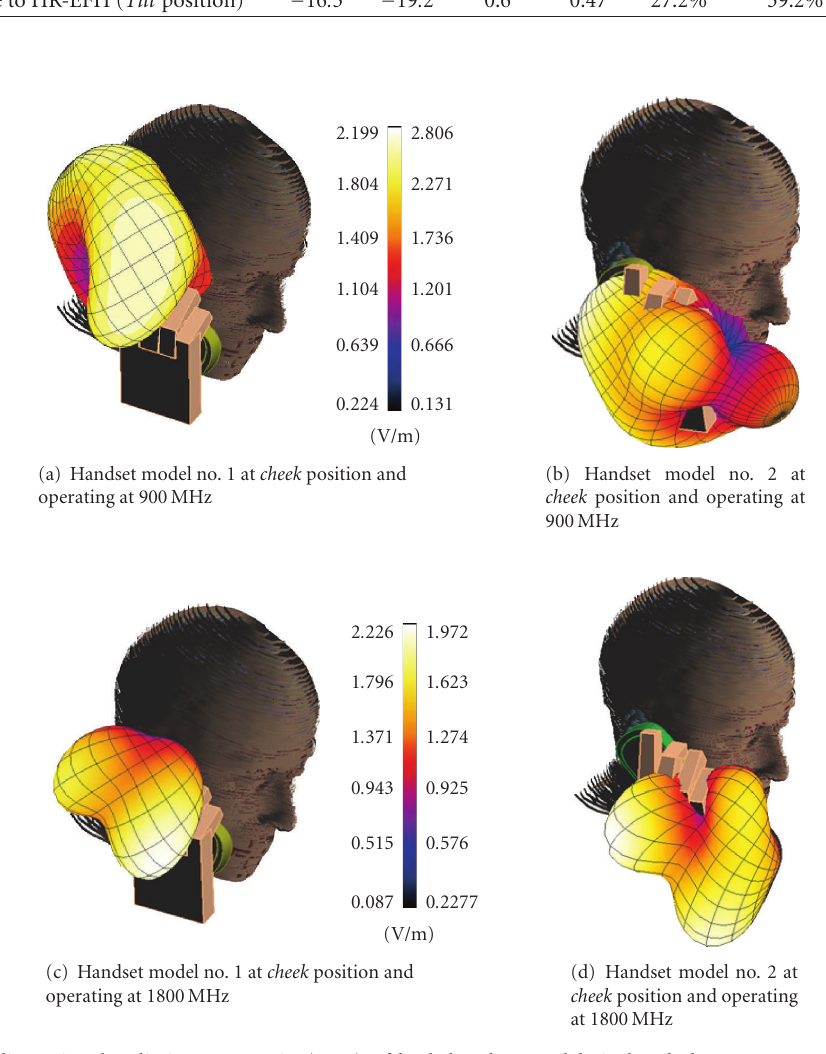
Figure 7: The three-dimensional radiation pattern in (V/m) of both handset models in hand close to HR-EFH at cheek position and operating at di ff erent